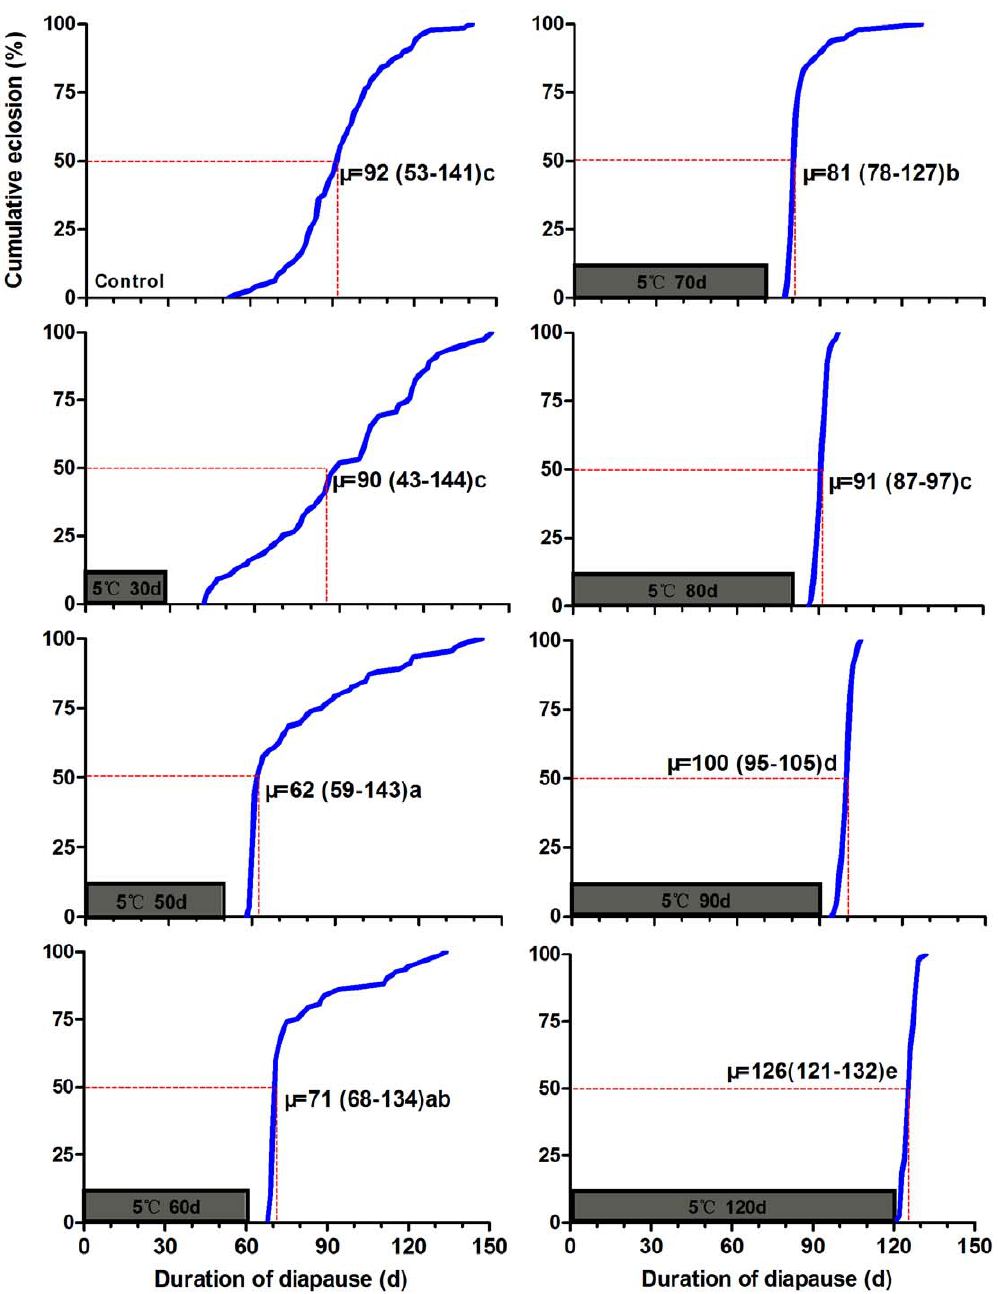
Figure 1. Cumulative percentage of butterfly eclosion in summer diapausing pupae of P.melete . The summer diapausing pupae were transferred to LD12.5:11.5 at 20 u C after exposure to 5 u C and DD for different days. The hatched bar indicates the period of cold exposure under constant darkness. Data were shown as the median (minimum value–maximal value); values followed by different letters are significantly different by Bonferroni test (P ,